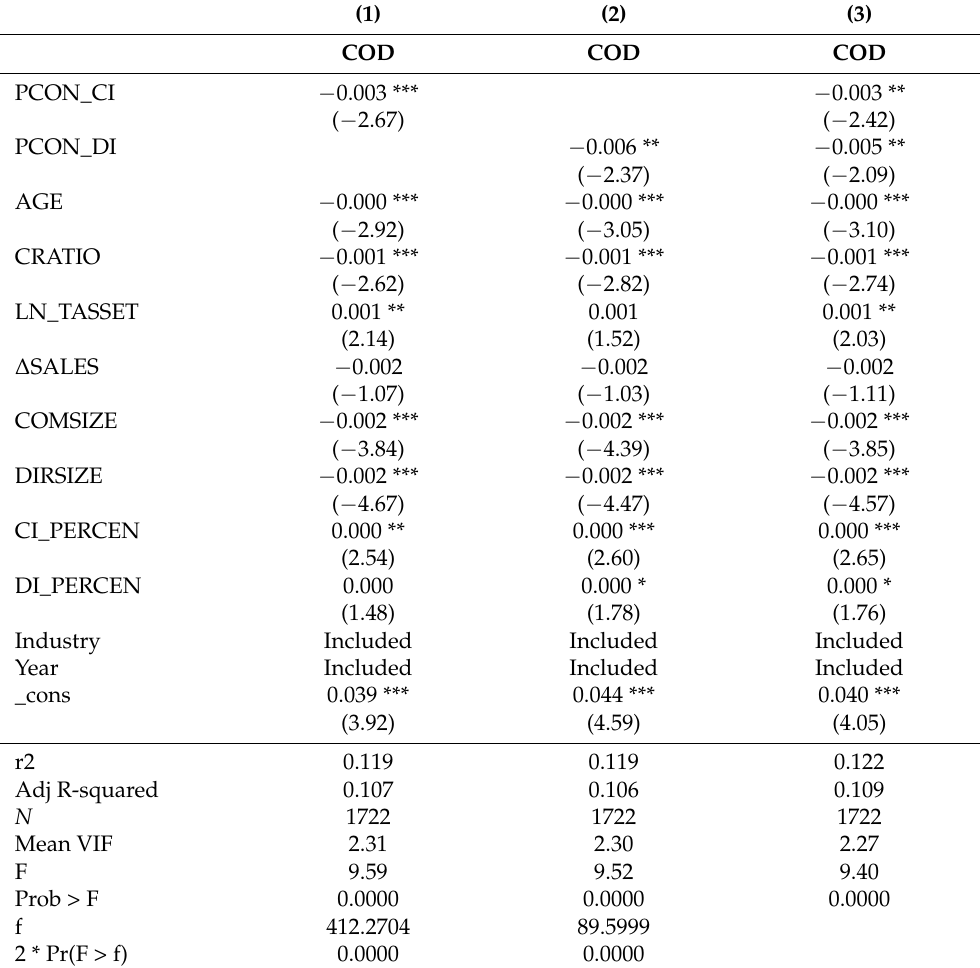
Table 8. OLS Regression